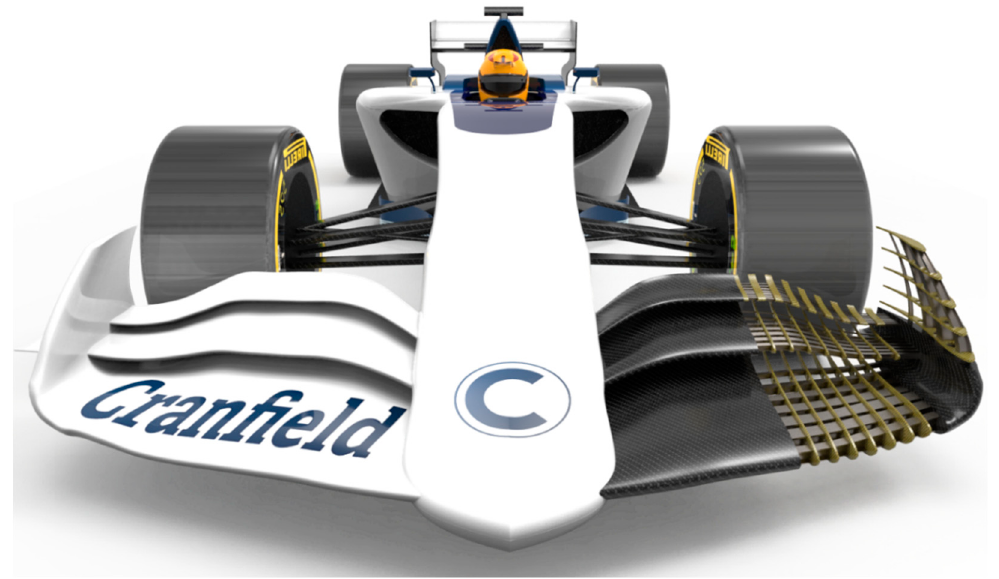
Figure 11. Selected structural components of the Formula One 2022 front wing.